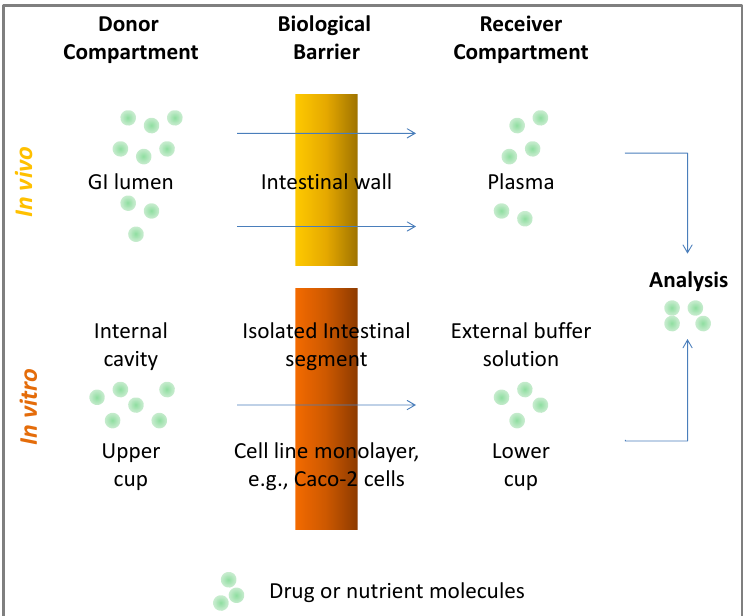
Figure 2. General components of bioavailability evaluation procedures. GI,